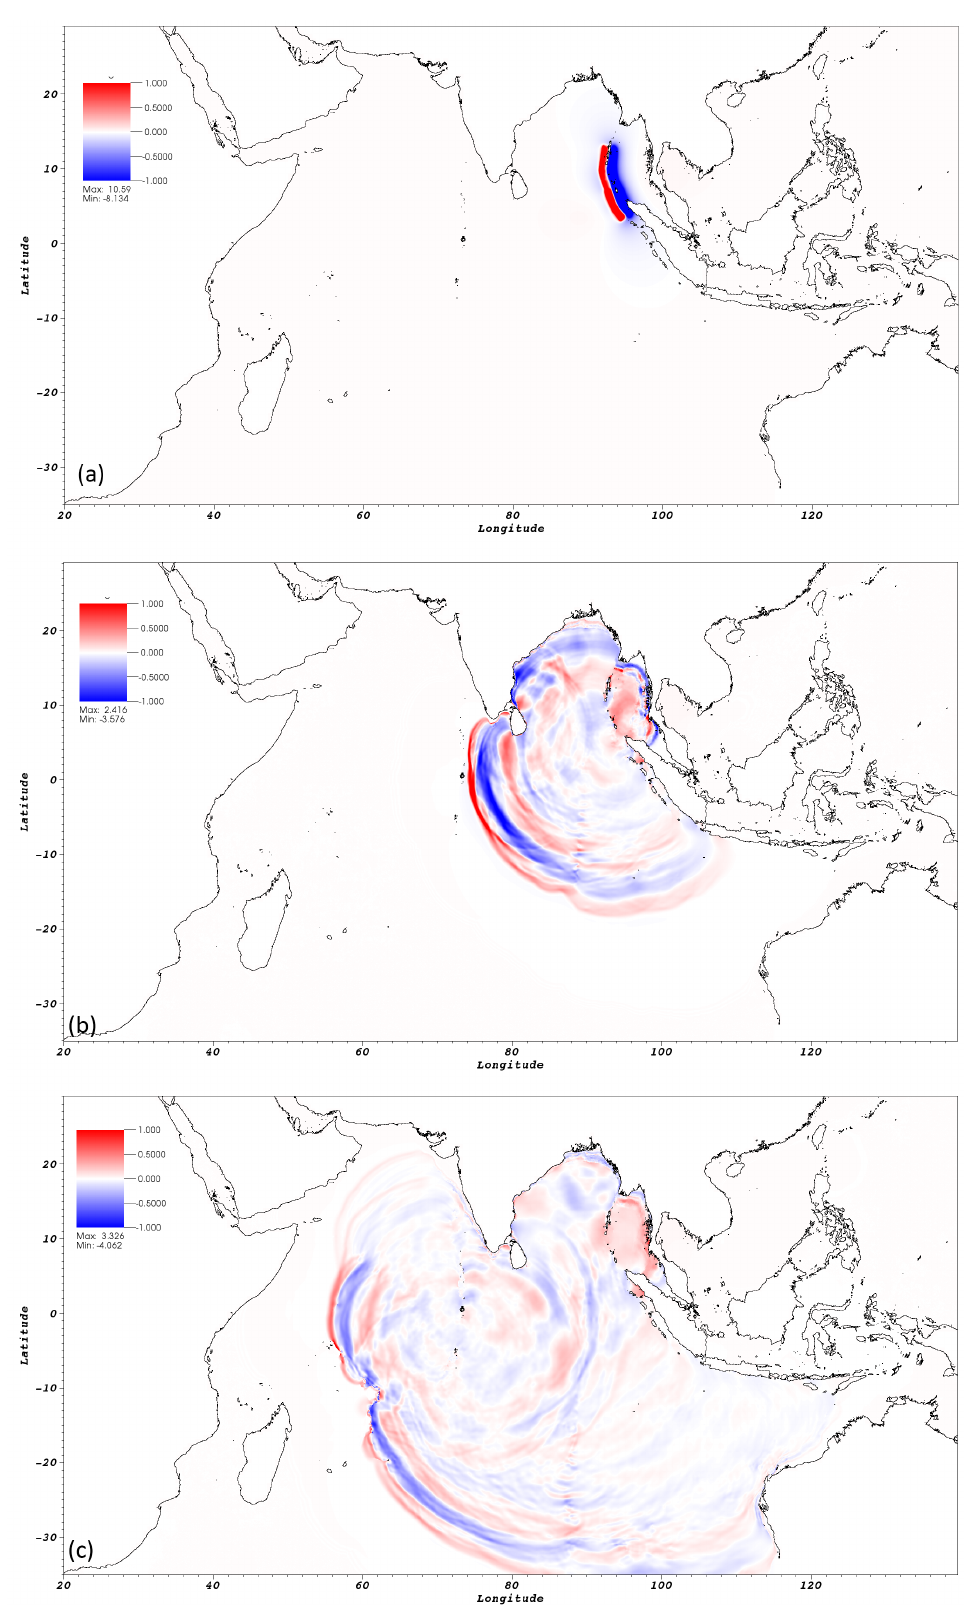
Figure 26. Snapshots every 3h (a) – (c) of the Indonesian 2004 tsunami propagation simulated by TRITON-G. (a) Time = 0h. Initial source in Sumatra. (b) Time = 3h. (c) Time =